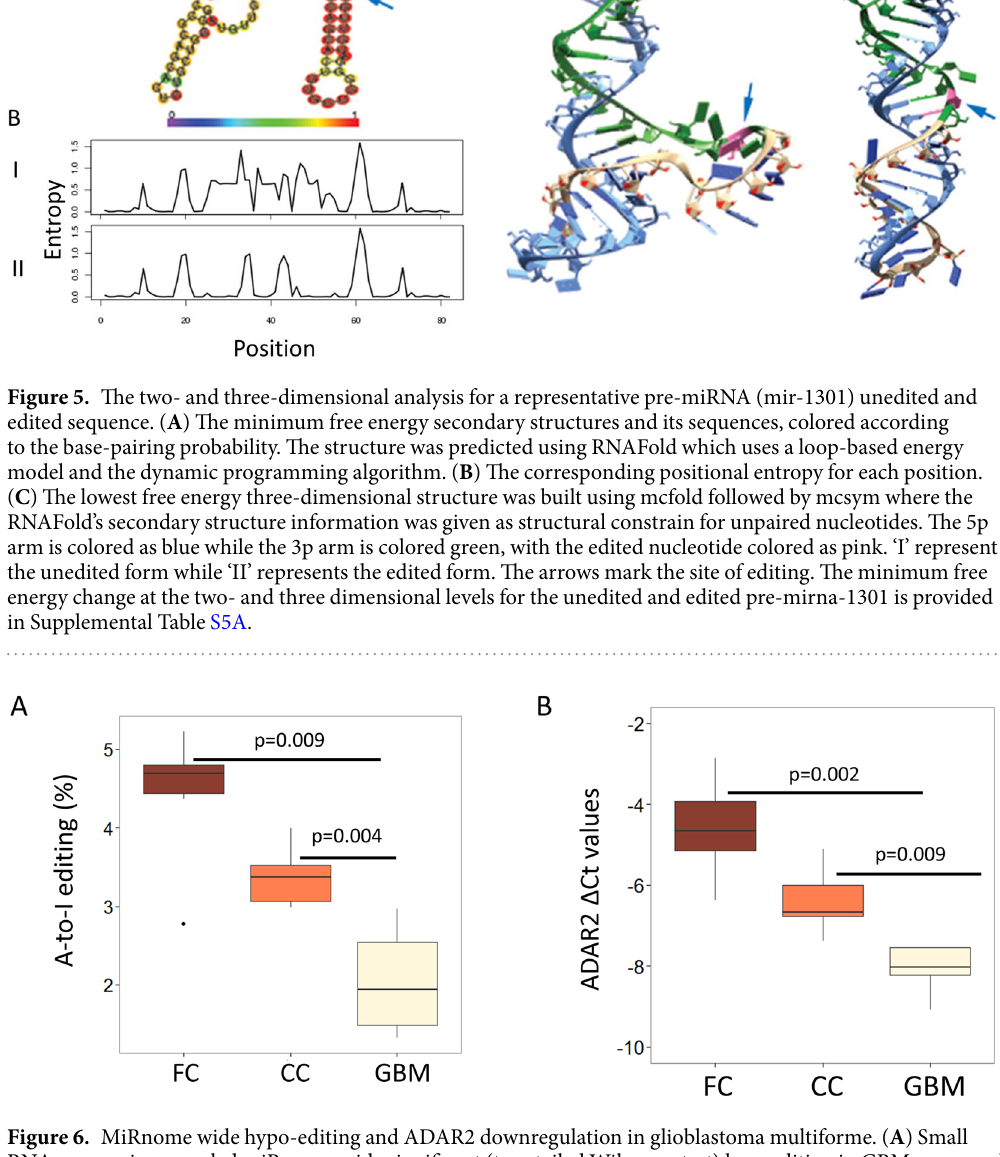
Figure 6. MiRnome wide hypo-editing and ADAR2 downregulation in glioblastoma multiforme. ( A ) Small RNA sequencing revealed miRnome-wide significant (two-tailed Wilcoxon test) hypoediting in GBM compared to FC (p = 0.009) and CC (p = 0.004) samples. ( B ) Real time PCR validation of ADAR2 in GBM samples compared to FC and CC samples. Y-axis shows Δ Ct values of ADAR2 in five FC, five CC and five GBM samples and B2M expression was used for normalization. ADAR2 is significantly (two-tailed t-test) downregulated in GBM compared to FC (p = 0.002) and CC (p = 0.009)